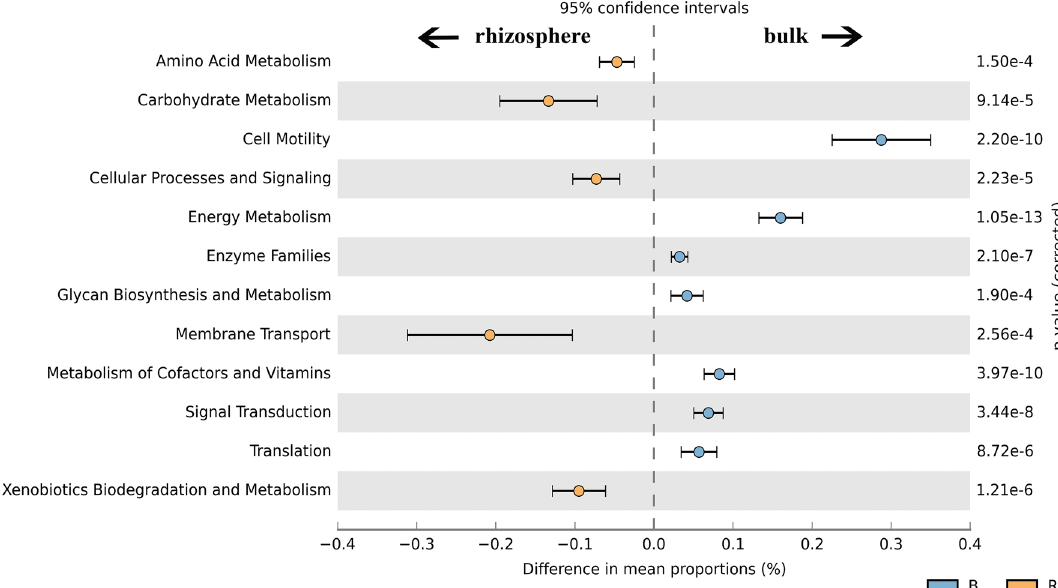
Figure 7. Extended error bar plot indicating the difference in mean proportion [%] of the predicted gene abundance in bulk (B, blue) and rhizosphere (R, orange) soil. p-values were corrected by using Bonferroni adjustment for multiple test correction.